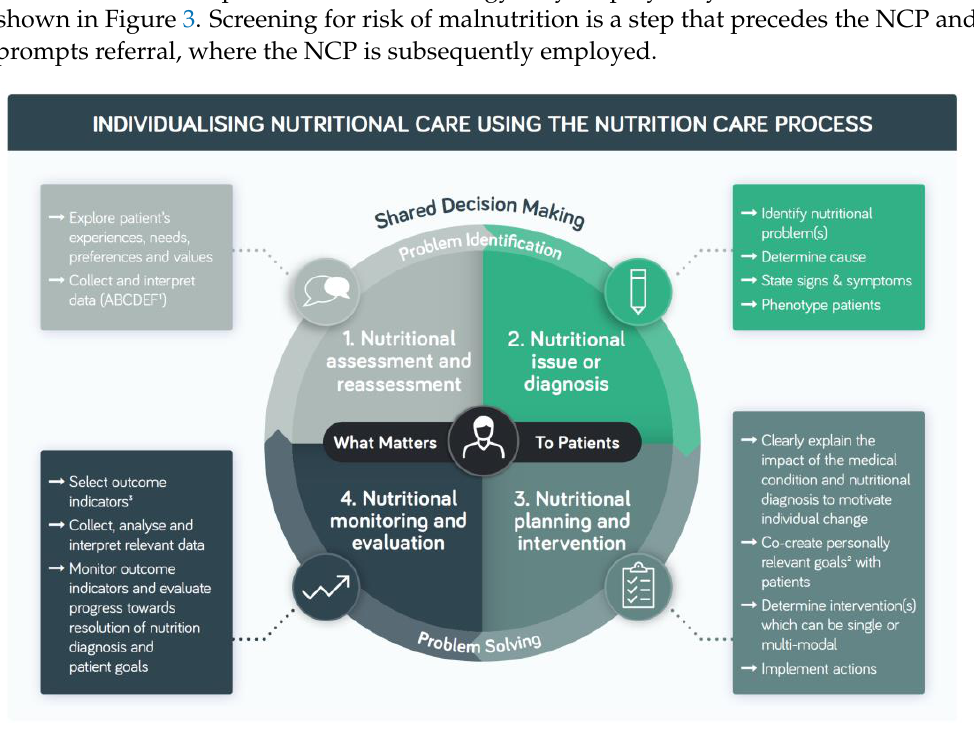
Figure 3. Individualising nutritional care in the management of disease-related malnutrition in adults using the nutrition care process (based on [53,54,56,59]). 1 Anthropometric, biochemical, clinical, dietary, environmental, economic, functional. 2 Goal = a measurable short-term aim set to be achieved by the next consultation or episode of care. 3 Outcome indicator = outcome indicator means a variable, parameter or tool that measures a change in status relating to the desired results of nutritional care.